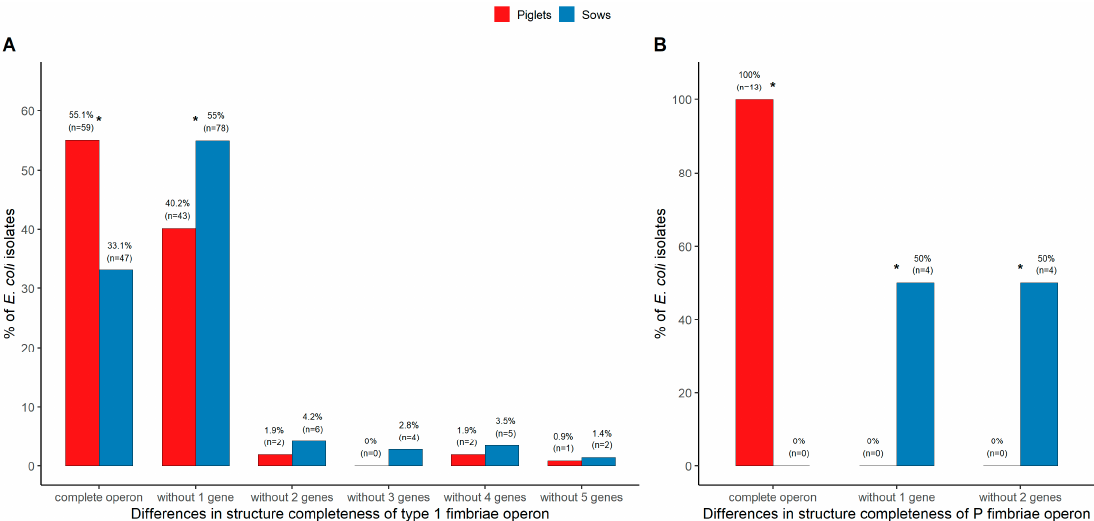
Figure 3. Frequency of the gene combinations within the structure of ( A ) type 1 and ( B ) P fimbriae operons among the E. coli isolates from piglets and sows. Note: The gene combinations within the structure of type 1 fimbriae operon: Complete operon: fimB-fimE-fimA-fimI-fimC-fimH ; Without 1